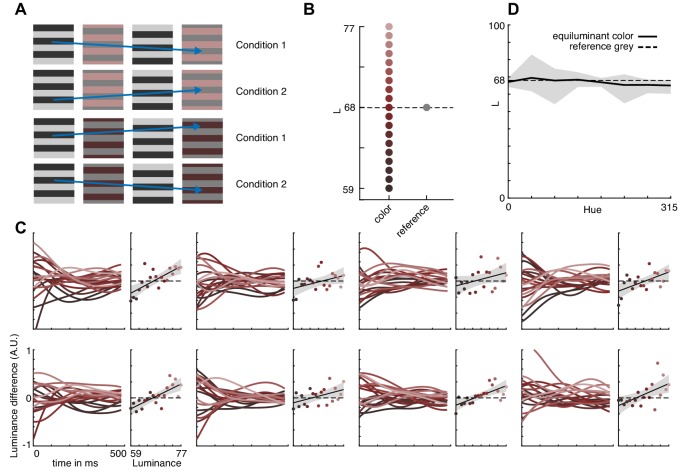
Perceptual equiluminance control.(A) To account for the possibility of luminance differences between stimuli due to different color sensitivities in macaques and humans, we performed a psychophysical experiment using a no-report minimum motion technique based on eye-movements in a third macaque monkey. We presented moving gratings consisting of alternating frames with luminance and color contrasts, respectively, with each frame being shifted by a quarter cycle for 500 ms. Color contrasts consisted of a reference gray and a color to be probed. If the probed color was darker than the reference gray, motion in one direction was perceived, if it was brighter, in the opposite direction. A color equiluminant to the reference gray should not evoke any stable motion percept. Stimuli were presented in two conditions: either a brighter probe color elicited upwards motion, or downwards motion. (B) This technique was applied to colors of 8 different hues, at 19 luminance levels. (C) We computed a luminance difference index based on eye position measurements, by calculating the difference in vertical eye trace curvature between conditions. For a color equiluminant to the reference gray, this measure was expected to be 0. The left plots show the luminance difference measure resolved in time, the right plots show the average over time. For all colors, 0 was crossed within the range of luminances probed, suggesting that this range included colors equiluminant to the reference gray. There was a significantly positive slope (pearson correlation, p<0.05) for 6 out of 8 colors, validating our approach. (D) Estimates of the zero-crossing for all eight hues are close to the L value of the reference gray, suggesting that psychophysically equiluminant colors in the macaque are close to those derived from human L*C*h - space. Shaded area shows 95% bootstrap confidence interval.